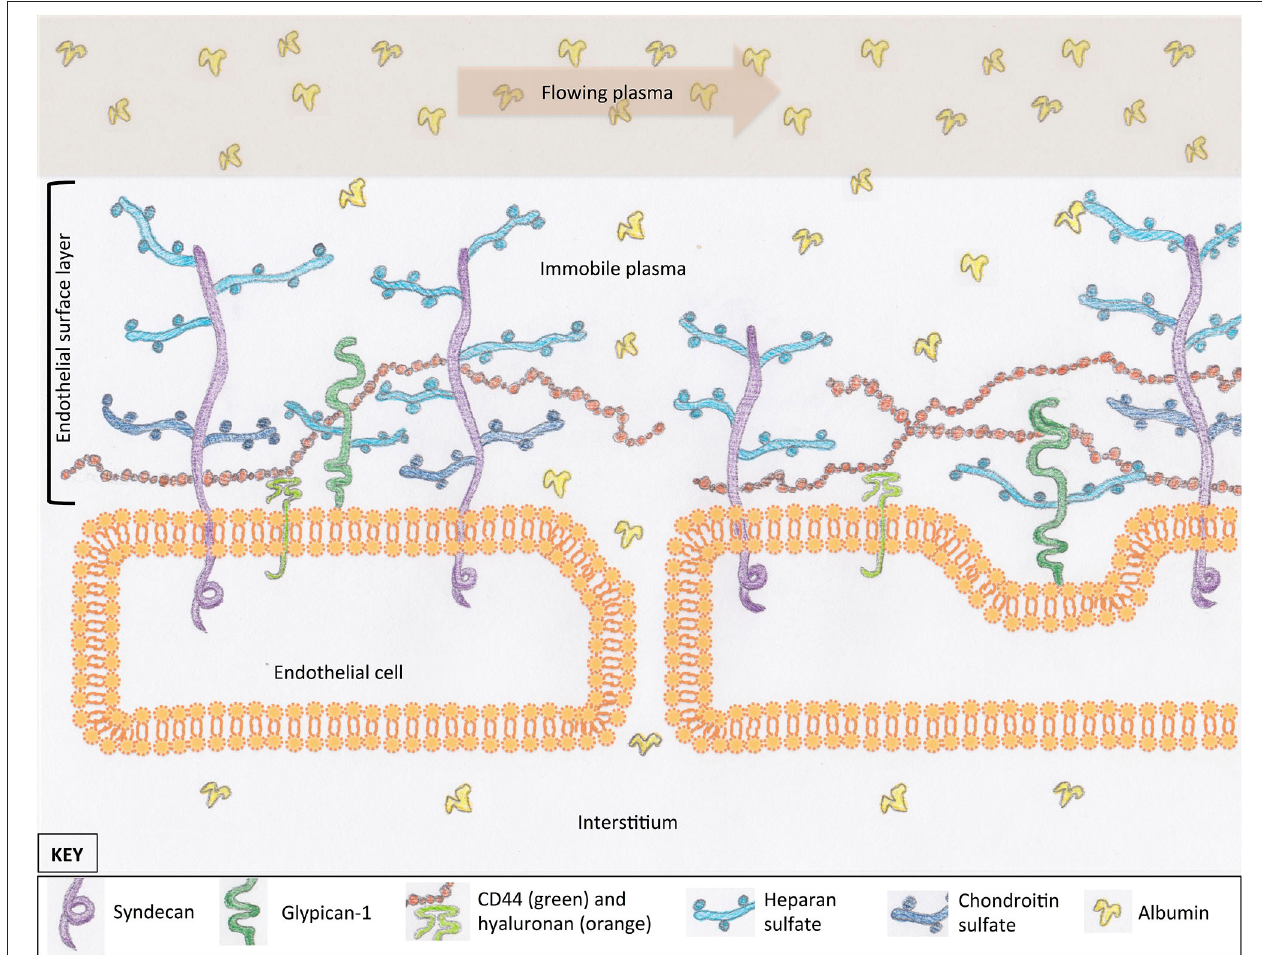
FIGURE 1 | The scaffold of the endothelial glycocalyx, within the endothelial surface layer, is provided by proteoglycans, syndecan (four subtypes), and glypican-1. Glycosaminoglycans are attached to proteoglycans (e.g., heparan sulfate) or the endothelial surface (hyaluronan). Molecules suspended in the plasma of the endothelial surface layer include proteins such as albumin. These proteins create a protein-poor sub-glycocalyx area that is important for transvascular colloid osmotic pressure balance. For simplicity, structures within the interendothelial cleft are not